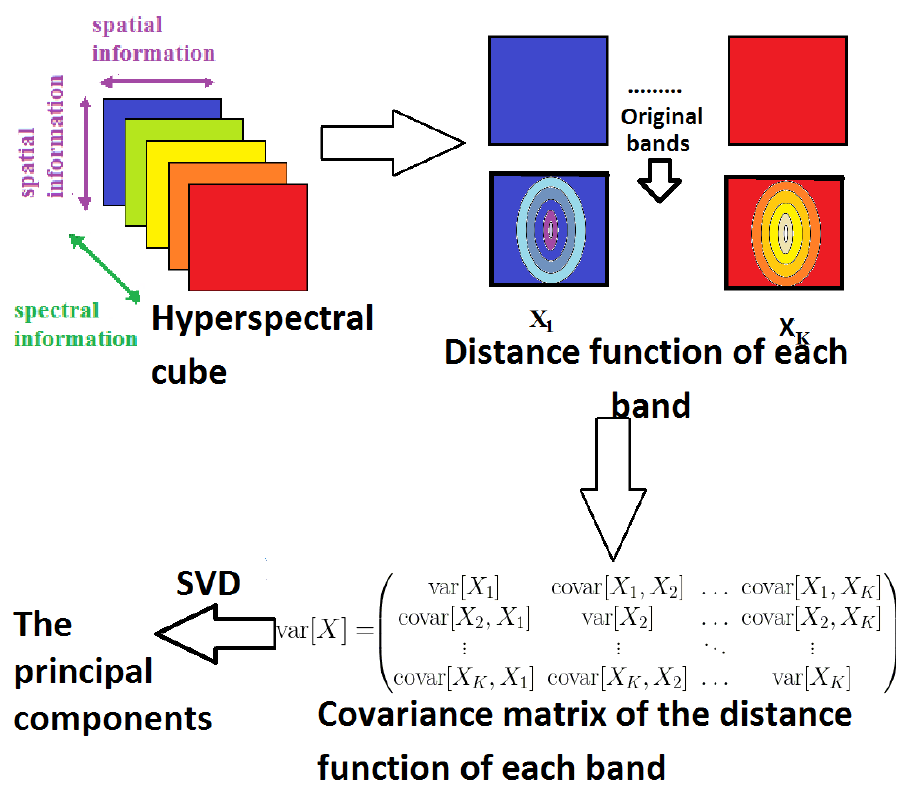
Figure 7. Process of distance function